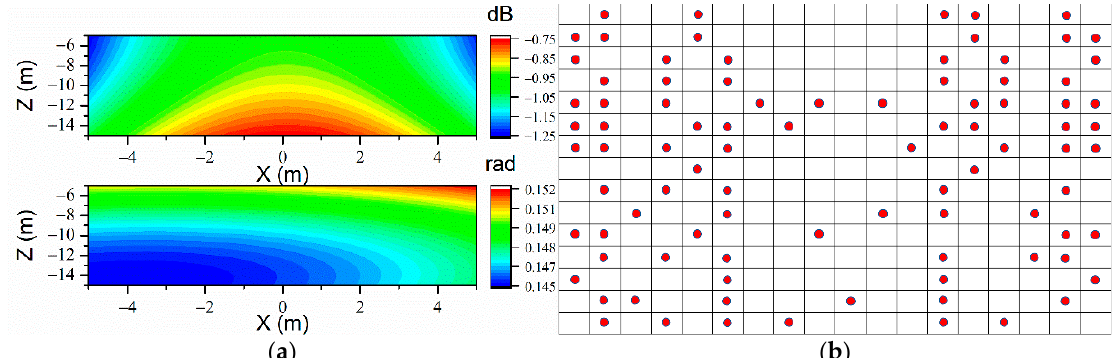
Figure 14. The sound prediction errors of VR-ESM on the prediction plane when h U = 0.2 m at the frequency of 71 Hz, L 1 = 42. ( a ) Upper: p E ; lower: ϕ E . ( b ) The arrangement of measurement points (90 points optimized with EFI).